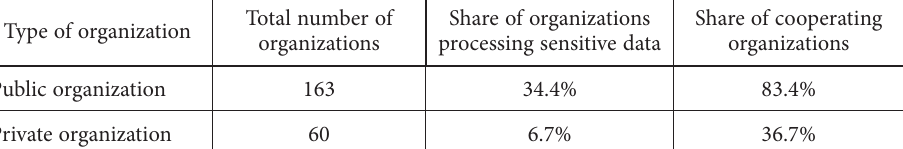
Table 3. Comparison of public and private organizations Total number of Type of organization